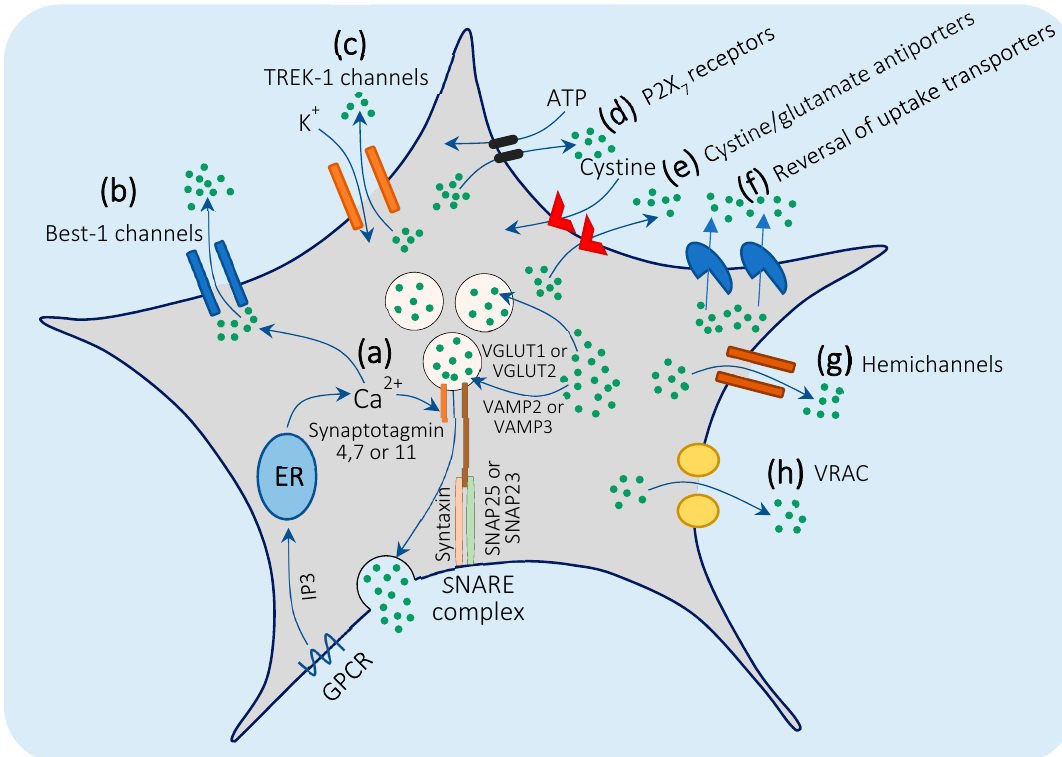
Figure 2. Mechanisms of astrocytic glutamate release: ( a ) Ca 2+ -mediated exocytosis: Astrocytes express VGLUT1 or VGLUT2, which transfer glutamate from the cytosol to the vesicles and vesicular VAMP2 or VAMP3 forms the SNARE complex by binding to syntaxin and SNAP25 or SNAP23 on the cell membrane. Stimulation of GPCRs in astrocytes induces IP3 formation and the release of Ca 2+ from the ER. This high [Ca 2+ ] i concentration is sensed by synaptotagmin 4, 7, or 11, which in turn induces fusion of the vesicles with the cell membrane and triggers glutamate release; ( b ) Best-1-mediated glutamate release: Stimulation of GPCRs in astrocytes, induces glutamate release through Bestrophin-1 channels in a Ca 2+ -dependent mechanism; ( c ) TREK-1 mediated glutamate release: Glutamate release occurs in exchange with K + uptake; ( d ) P2X 7 ATP receptors: Glutamate is released in exchange with the uptake of ATP; ( e ) cystine/glutamate antiporters: Glutamate is released from astrocytes in exchange with cystine uptake; ( f ) reversal of uptake transporters: Occurs with ATP depletion or reversal of the Na + /K + ratio, as in cases of severe ischemia or stroke; ( g ) gap junction hemichannels: Formed by connexin and pannexin proteins that permit the passage of several molecules, including glutamate, from astrocytes to the extracellular space; ( h ) volume-regulated anion channels (VRACs): In case of brain edema, VRACs are activated in swollen astrocytes, in which they open and release